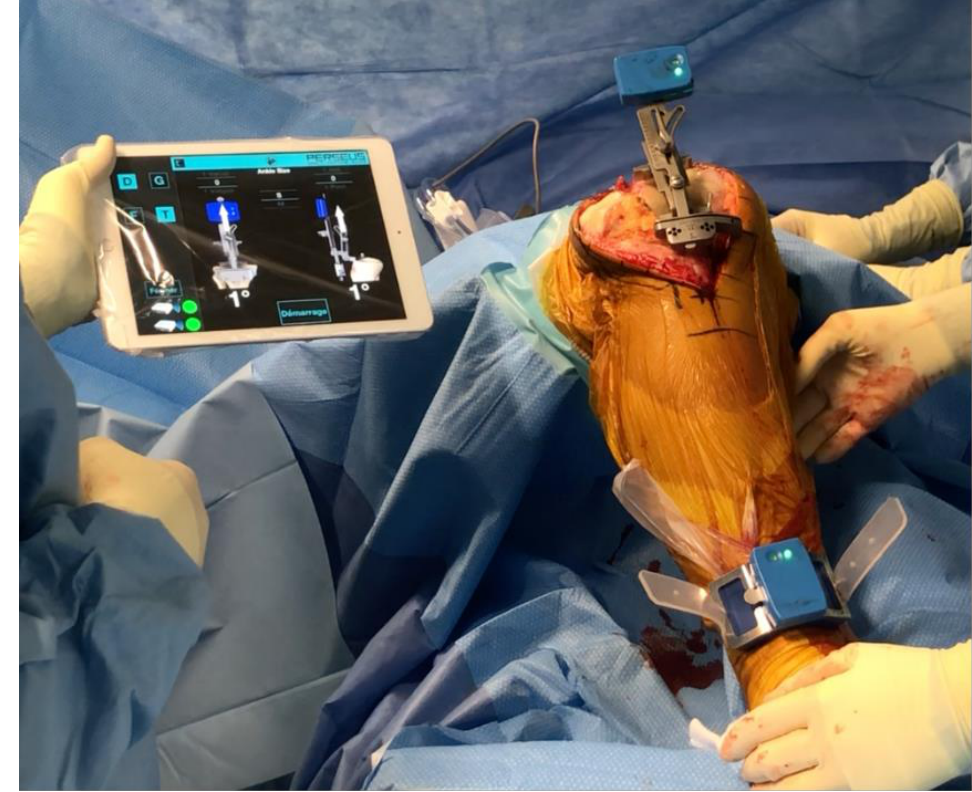
Figure 3. The accelerometer is a handheld device used within the operative field to determine the resection planes of the proximal tibia. This system guides resection angles in the coronal and sagittal planes (Perseus, Orthokey).